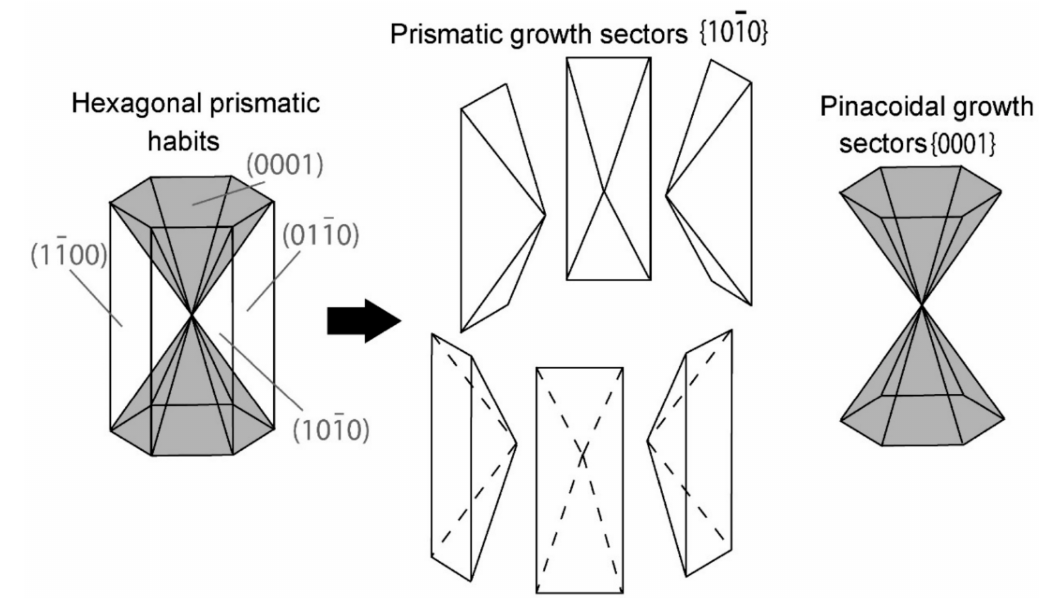
Figure 5. Habits of emerald crystals, characterized by eight main faces and their corresponding growth sectors: Six {1010} first order prismatic faces and two pinacoidal {0001}